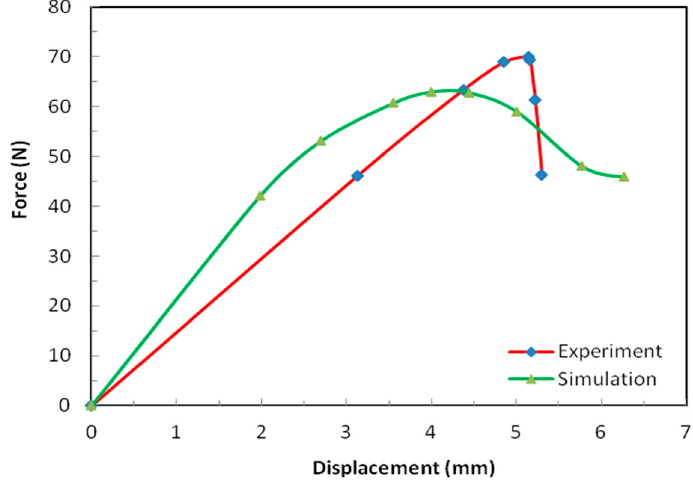
Figure 10. Four-point bending results of the test and the simulation.